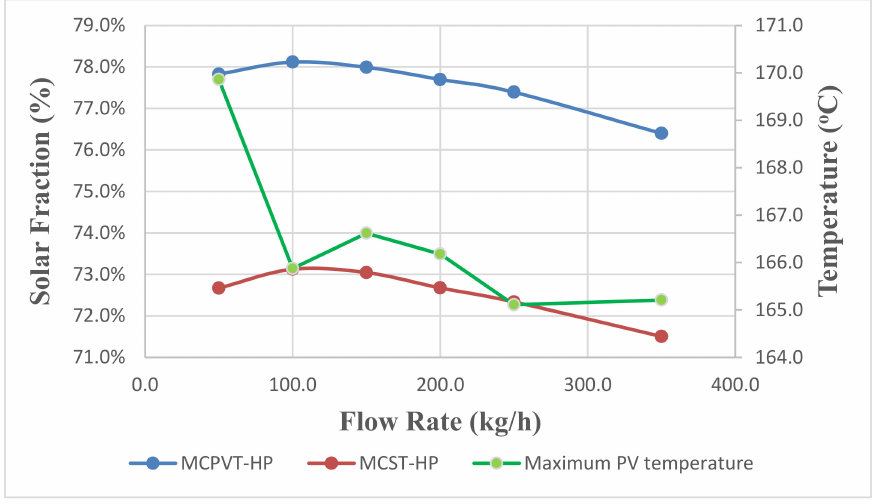
Figure 11. MCPVT-HP and MCST-HP solar collector flow-rate sensitivity